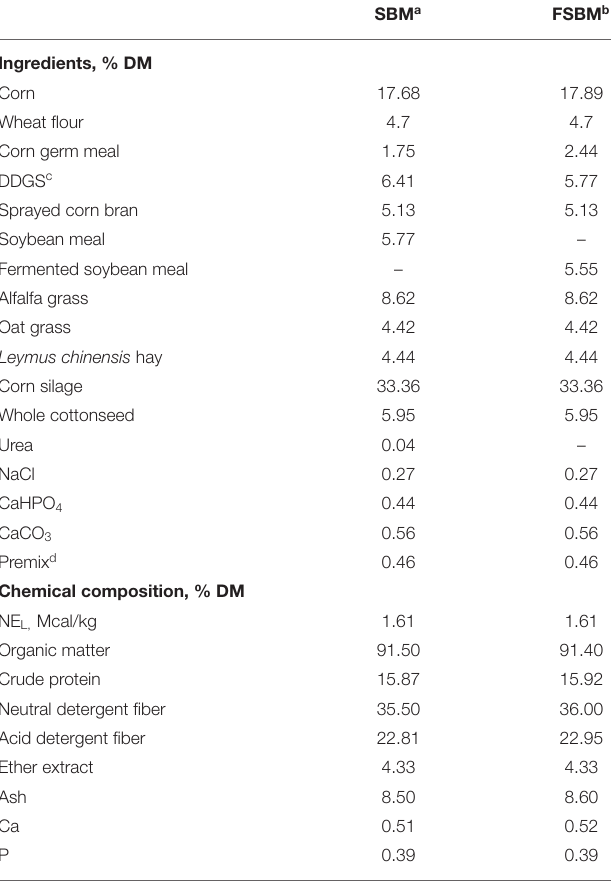
TABLE 1 | Ingredients and chemical composition of rations for the SBM group and FSBM